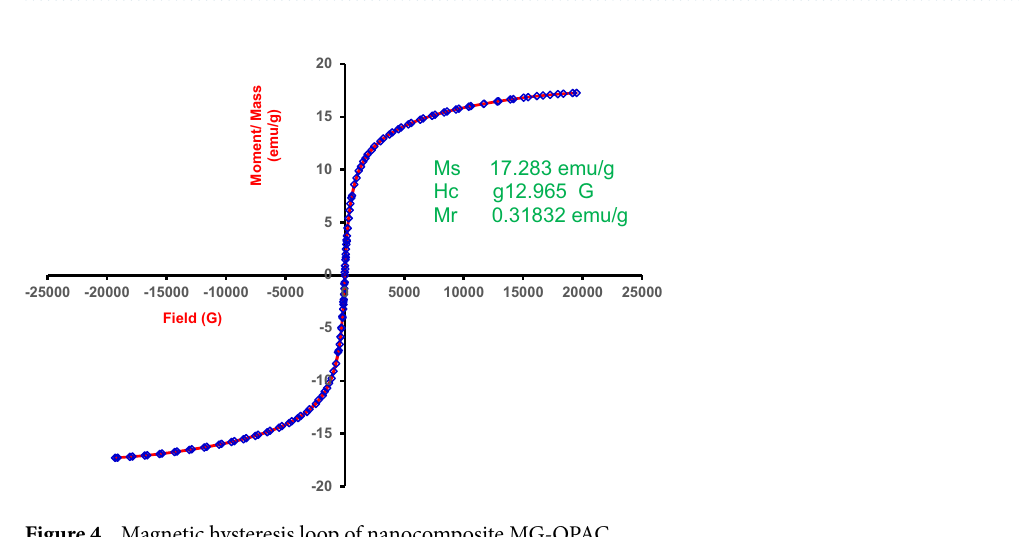
Figure 4. Magnetic hysteresis loop of nanocomposite MG-OPAC